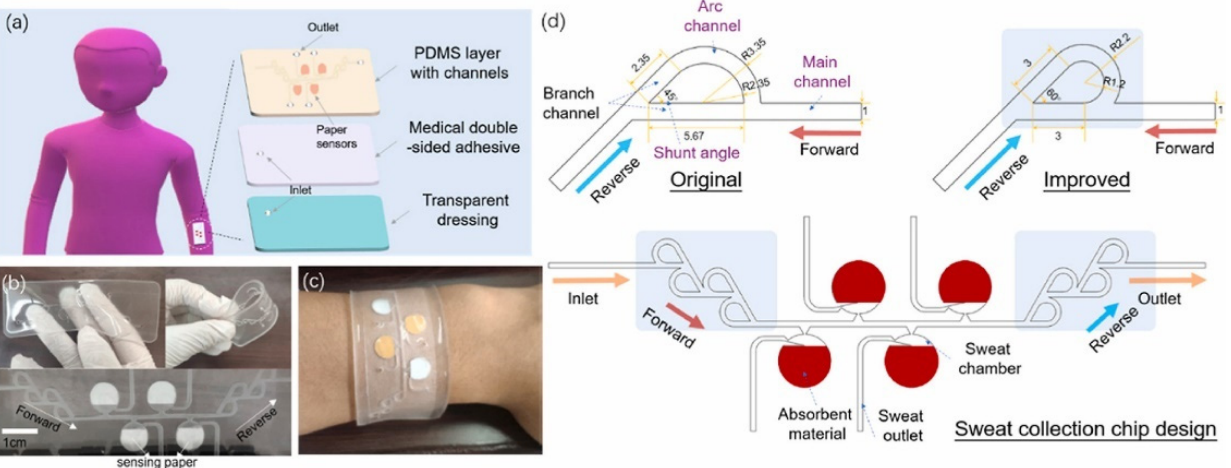
Figure 6. A proof-of-concept of the TV microchannels for sweat collection in a wearable device. ( a ) The structure of the sweat collection devices. ( b ) the TV microchannels and the paper sensing components. ( c ) The sweat collector device with detected colorimetry. ( d ) The primary mechanism of the sweat collection chip. Reprinted with permission from [51] copyright © 2022 Elsevier.